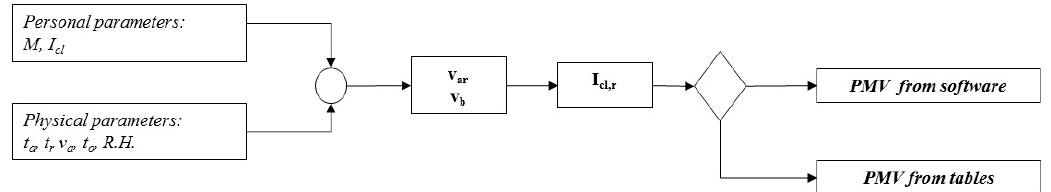
Figure 2. Flow chart for the calculation of PMV as required by ISO 7730 Standard [9].